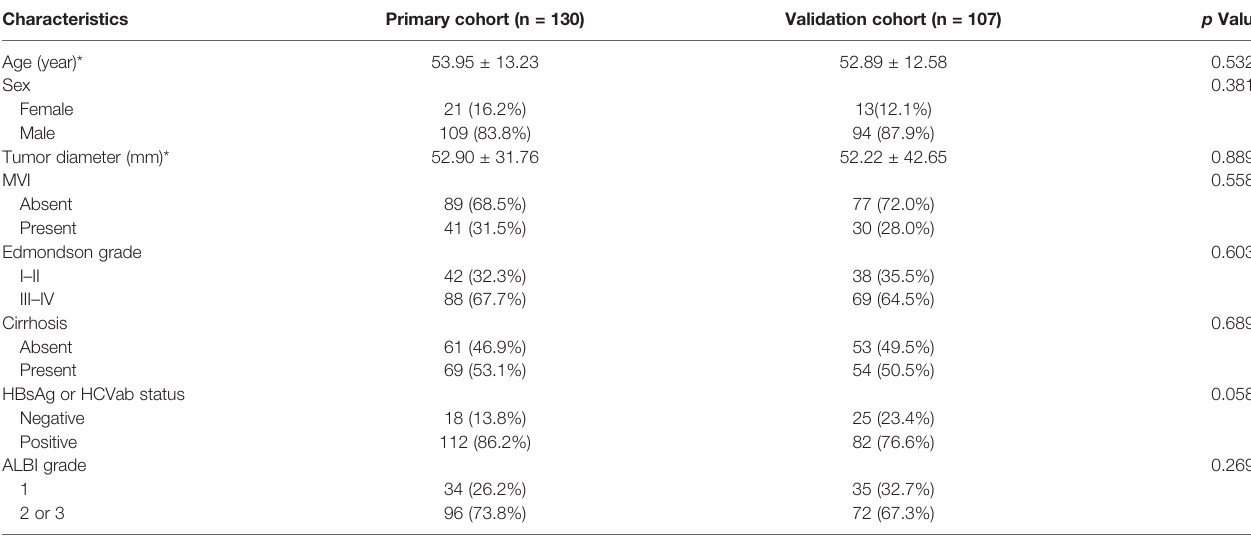
TABLE 1 | Baseline characteristics of the HCC patients in the primary and validation cohorts.